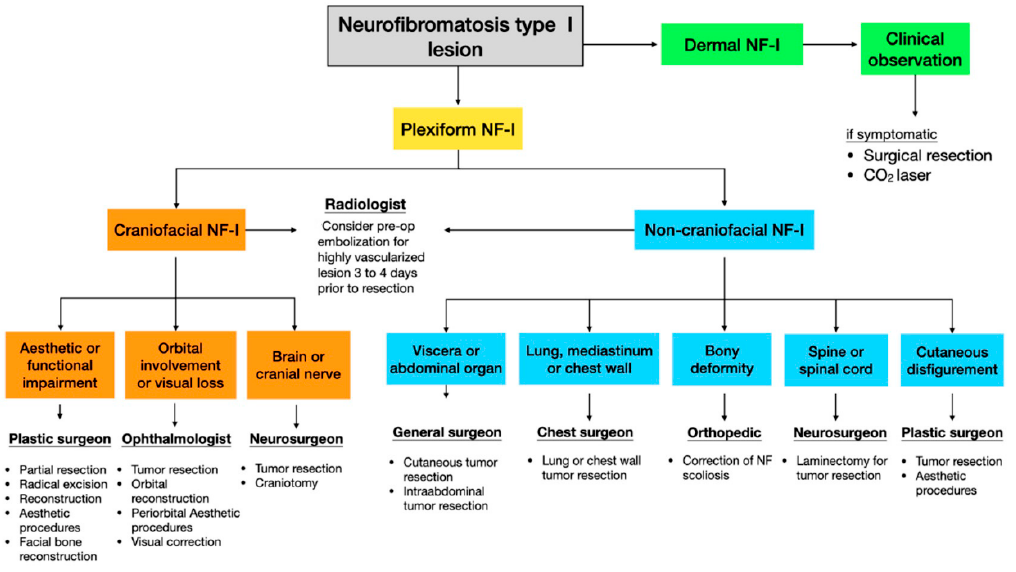
Figure 1. Multidisciplinary team-based treatment algorithm for neurofibromatosis type I